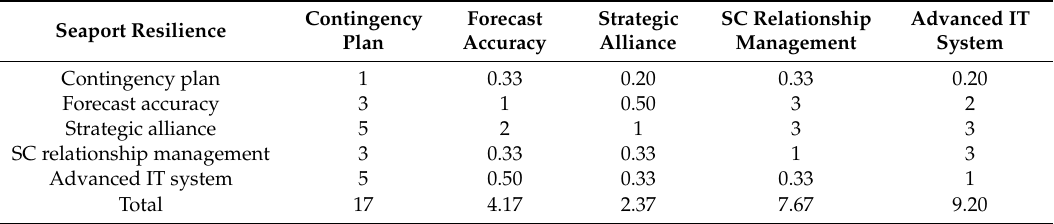
Table 4. Tabulation of data on the assessment of seaport resilience criteria by all respondents.